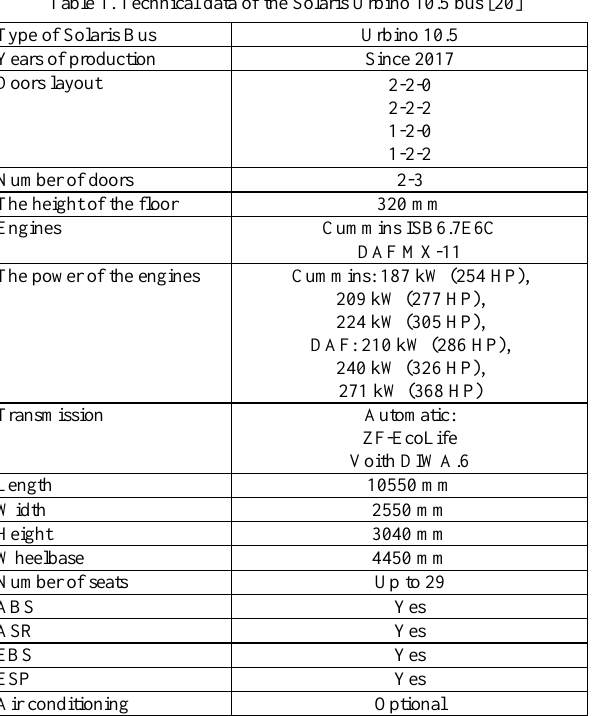
Table 1. Technical data of the Solaris Urbino 10.5 bus [20]